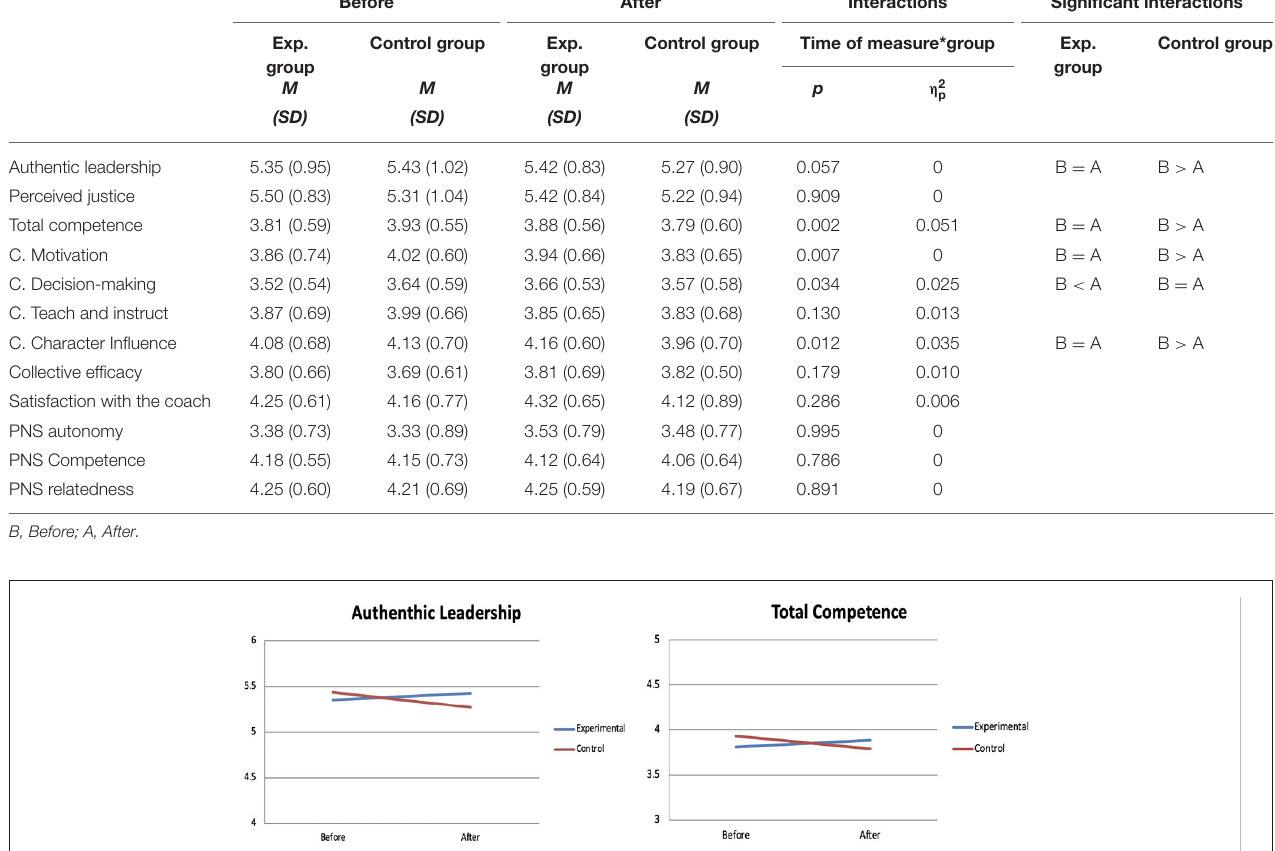
TABLE 3 | Means and standard deviations of the players in the experimental and control groups before and after the intervention and interactions between time of measure*group. Before After